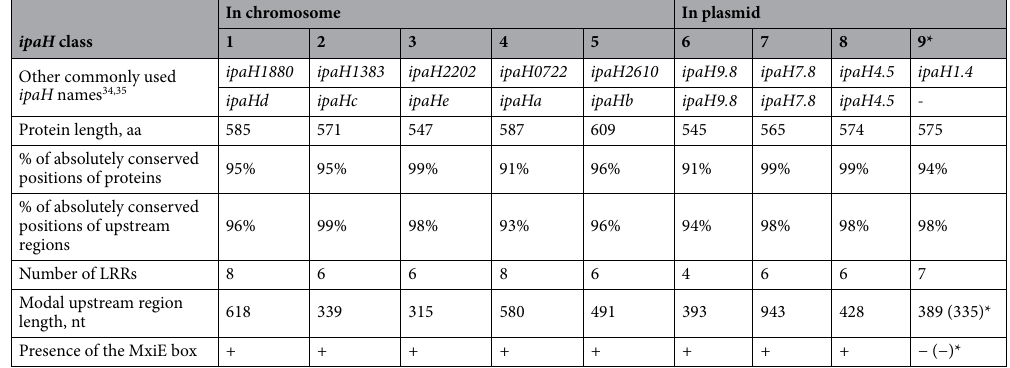
Table 2. Classification of the ipaH genes from Shigella : coding sequences and upstream regions. *The numbers in parentheses show the values for paralogs.